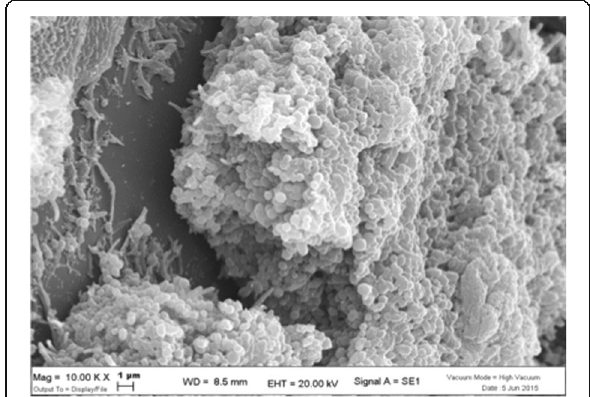
Fig. 4 Aligner cleaned by rinsing with water alone (method